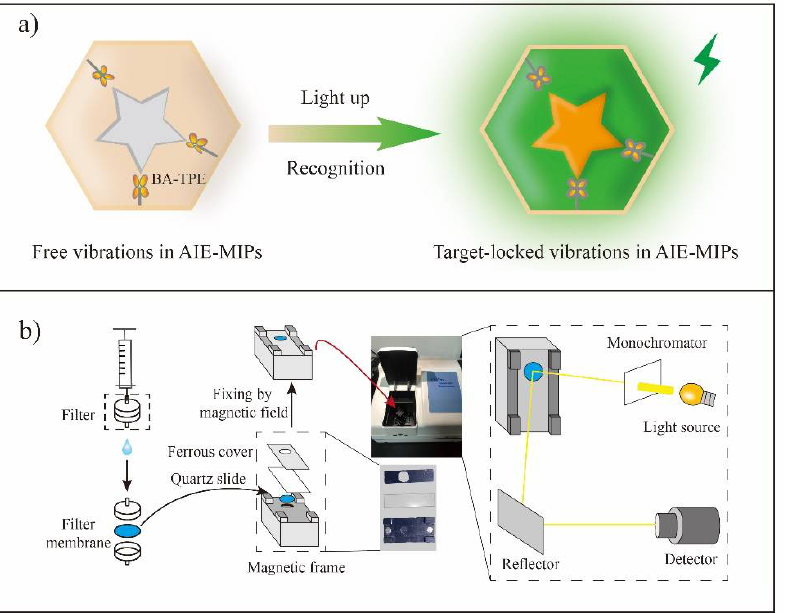
Figure 5. MIP-based sensor. a ) The principle of AIE-MIP sensor; b ) The illustration of main preparation steps of an AIE-MIP membrane and fixing the AIE-MIP membrane with a magnetic frame for fluorescence detection. This figure is from Yan et al. [95].